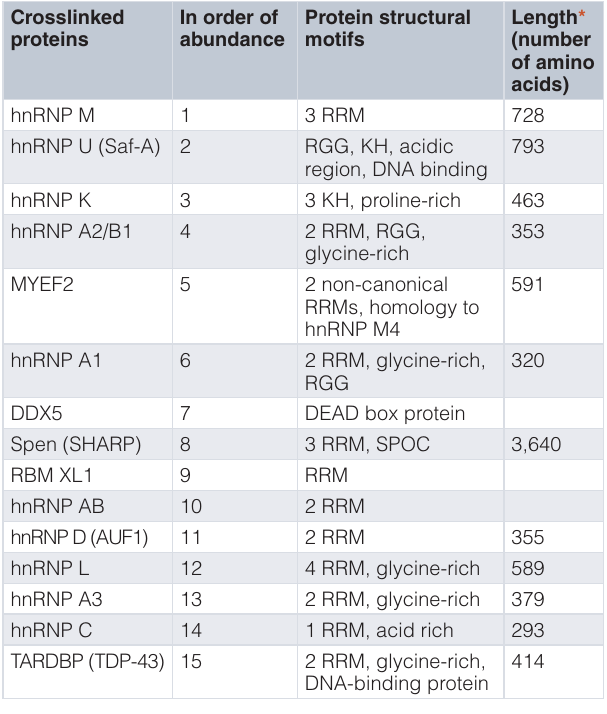
Table 1. Top 15 Xist-binding proteins from Chl-MS recovery in mouse cells 14